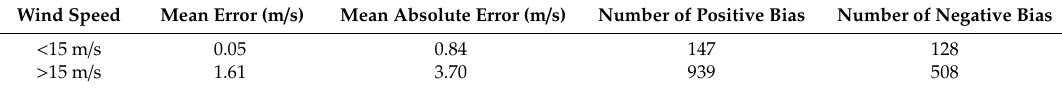
Figure 8. The error distribution of wind speeds less than 15 m / s and greater than 15 m / s. ( a ) The distribution of errors with the variation of CYGNSS wind speed below 15 m / s; ( b ) The distribution of errors with the variation of CYGNSS wind speed above 15 m / s. The colors bar (from cool to warm) represents the change of scatter density from small to large values in a given range. Table 3. The mean error and mean absolute error of wind speed between CYGNSS and